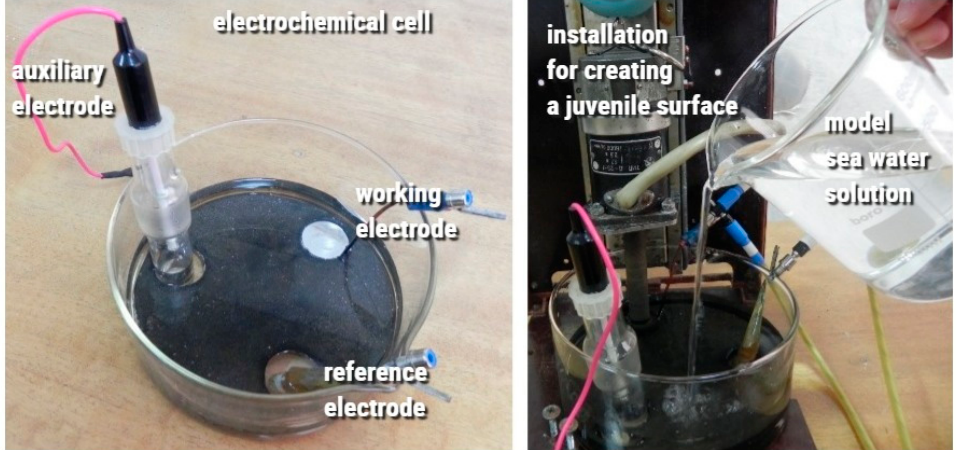
Figure 5. The preparation operation stage of the laboratory experiment.